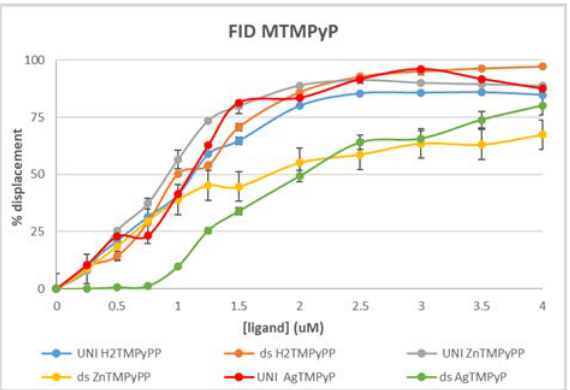
Figure 18. G4-FID assay performed for the in PBS at 25 °C with the Ag II TMPyP using the unimolec- ular GQ (AG 3 (T 2 AG 3 ) 3 ) and double-stranded salmon sperm. A comparison with the results obtained with the H 2 TMPyP and the Zn II TMPyP is presented.